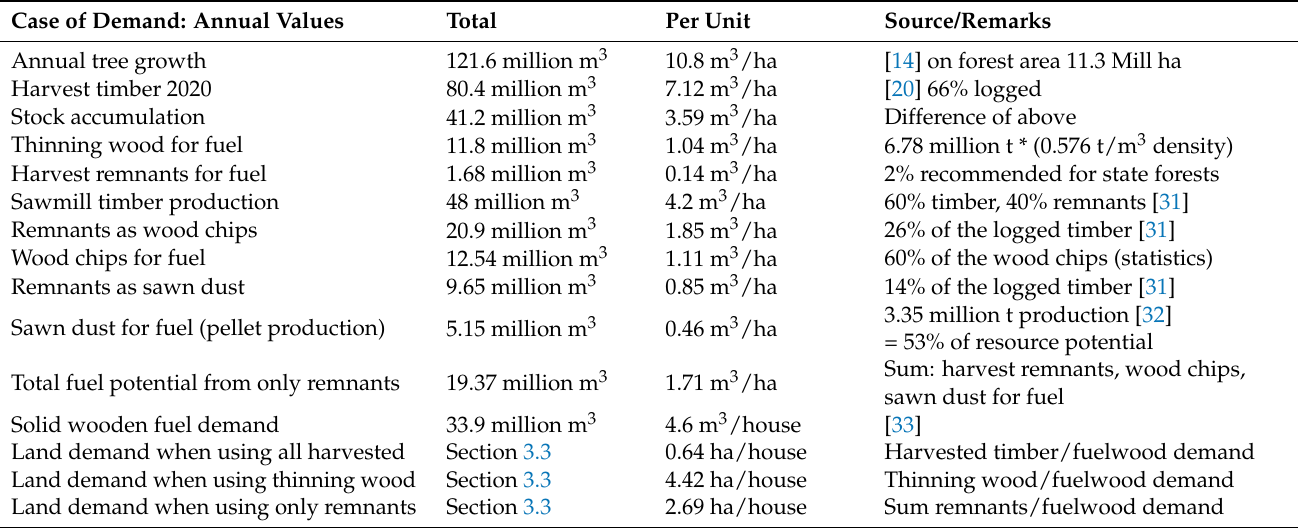
Table 1. Use cascade of timber and firewood from forestry or wood production residues.